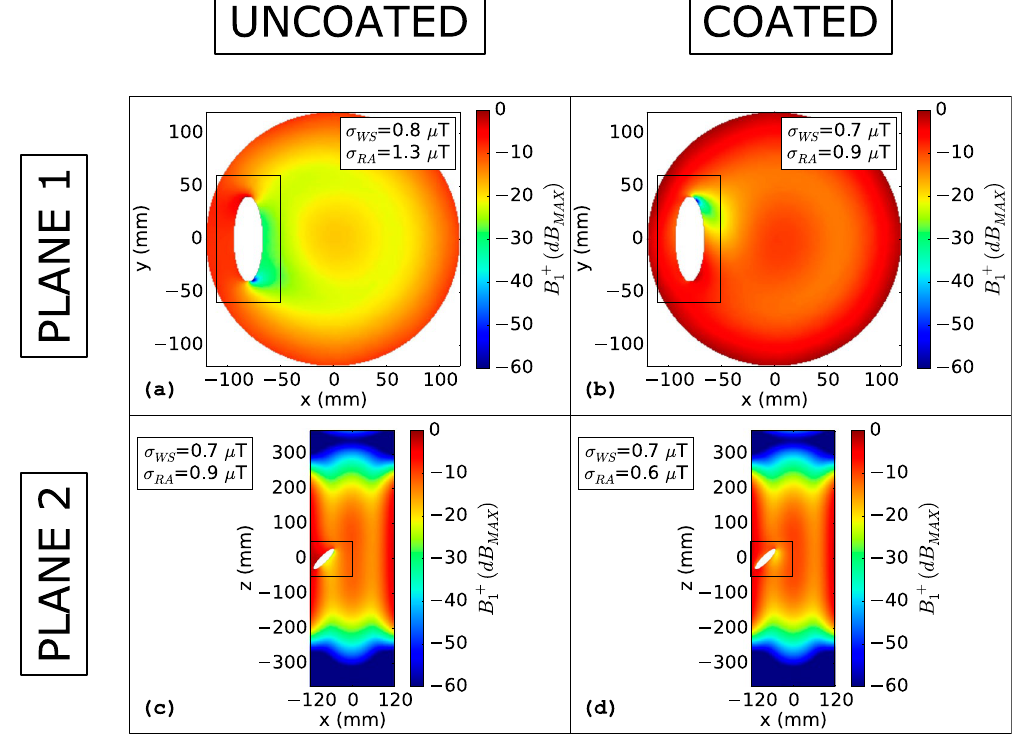
Figure 5. B 1 + ( dB MAX ): Lateral metallic disc. B 1 + ( dB MAX ) evaluated for the disc plunged into the phantom in a lateral position ( − 80 mm from the phantom centre to the disc centre). Figures ( a ) and ( b ) depict the uncoated and coated object situation, respectively, for the transverse plane that cuts the disc in two equal parts along the longitudinal direction. Figures ( c ) and ( d ) depict the uncoated and coated object condition, respectively, for the longitudinal plane that cuts the phantom in two equal parts. The rectangular areas represent the reduced areas in which the standard deviation ( σ RA ) was computed. σ WS represents the standard deviation computed on the whole